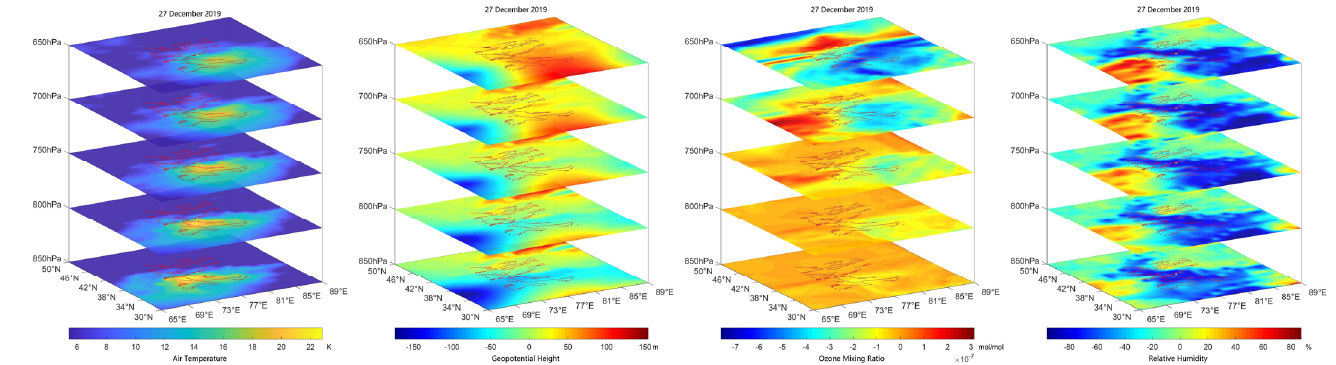
Figure 6. Composite atmospheric anomaly map associated with earthquake in Jiashi on 27 December. The epicenter and faults are shown by yellow point and red lines, respectively. For each row, the subplots represent air temperature, geopotential height, ozone mixing ratio and relative humidity from left to right.